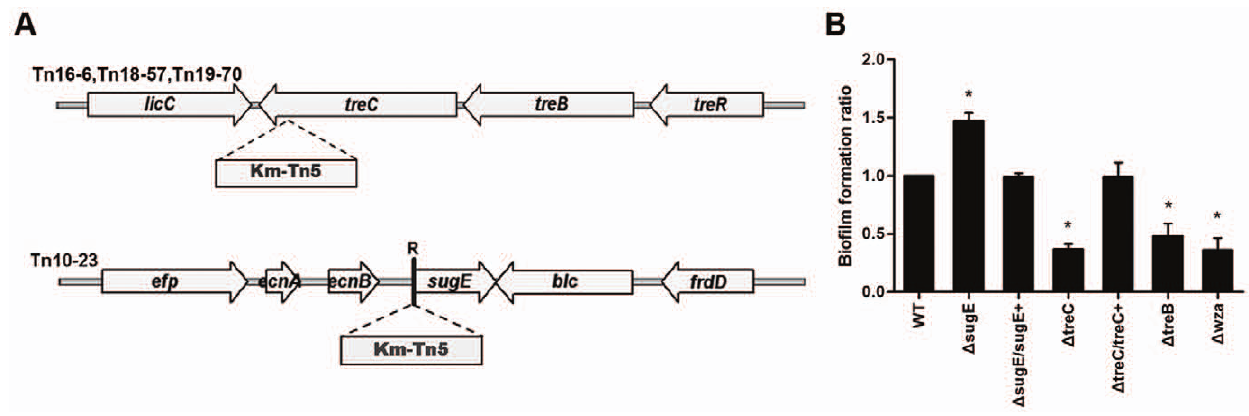
Figure 4. Schemas of transposon-insertion site and biofilm formation of K.pneumoniae NTUH-K2044 and isogenic mutants. A, Schemas of transposon-insertion site of treC mutant (Tn16-6, Tn18-57, and Tn19-70) and sugE mutant (Tn10-23). Broad arrows, the locations and orientations of the open-reading frames. R, the ribosomal binding site. B, Biofilm formation of K. pneumoniae NUTH-K2044, the deletion mutants, and the complementation strains. Bacteria were grown at 37 u C in polystyrene plates containing fresh Luria-Bertani broth for 5 h. The sessile bacteria were stained with crystal violet, washed to remove unbound cells, eluted with 95% ethanol, and monitored the absorbance at 550 nm. *, p , .05. Data are representative of three independent experiments (triplicate in each experiment).